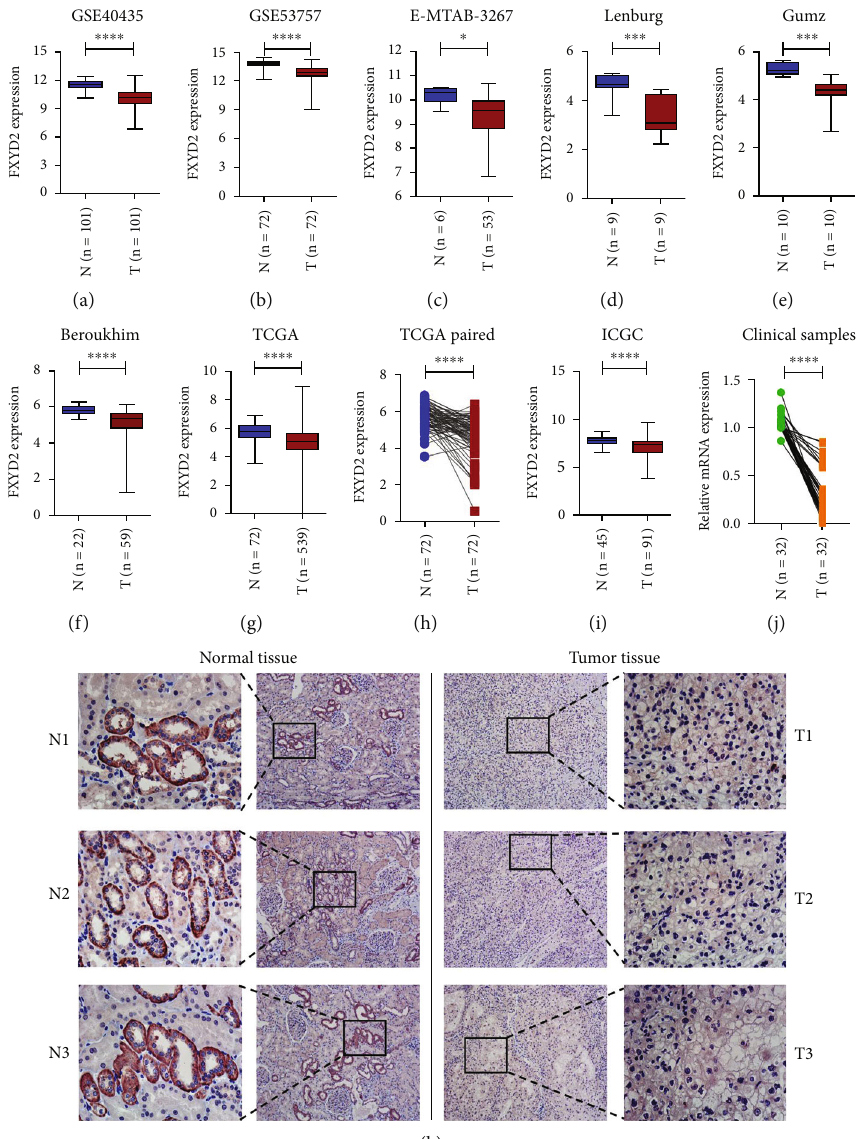
Figure 1: Di ff erential expression analysis of FXYD2 in ccRCC and normal tissue. (a – g) (i) FXYD2 expression was downregulated in ccRCC tissue compared with normal tissue in GSE40435, GSE53757, E-MTAB-3267, Lenburg, Gumz, Beroukhim, TCGA, and ICGC cohort, respectively. (h) The paired expression pattern of the FXYD2 expression showed downregulated pattern in ccRCC tissue compared with adjacent normal tissue. (j) RT-qPCR analysis of ccRCC and normal tissue validated the di ff erence of expression. (k) IHC analysis of ccRCC and normal tissue validated the di ff erence of expression. CcRCC: clear cell renal cell carcinoma; TCGA: The Cancer Genome Atlas; ICGC: International Cancer Genome Consortium; RT-qPCR: quantitative real-time polymerase chain reaction; IHC: immunohistochemistry; ∗ P < 0 : 05 , ∗∗ P < 0 : 01 , ∗∗∗ P < 0 : 001 , and ∗∗∗∗ P < 0 : 0001